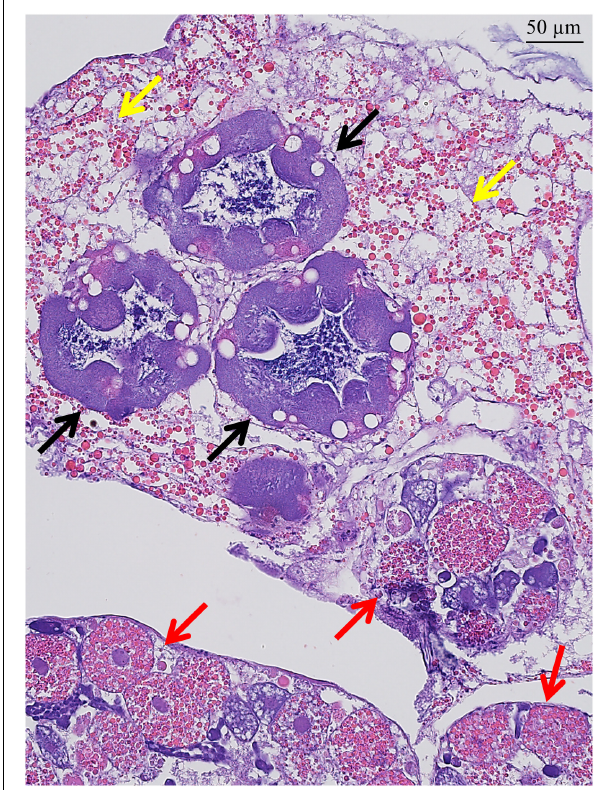
FIGURE 2 | H&E stained sub-mantle tissue features. Transverse section containing cement glands (deep purple; black arrows) and ovarioles (red arrows) with oocytes in various developmental stages surrounded by connective tissue with visible lipid granules (yellow arrows). Scale bar = 50 µ